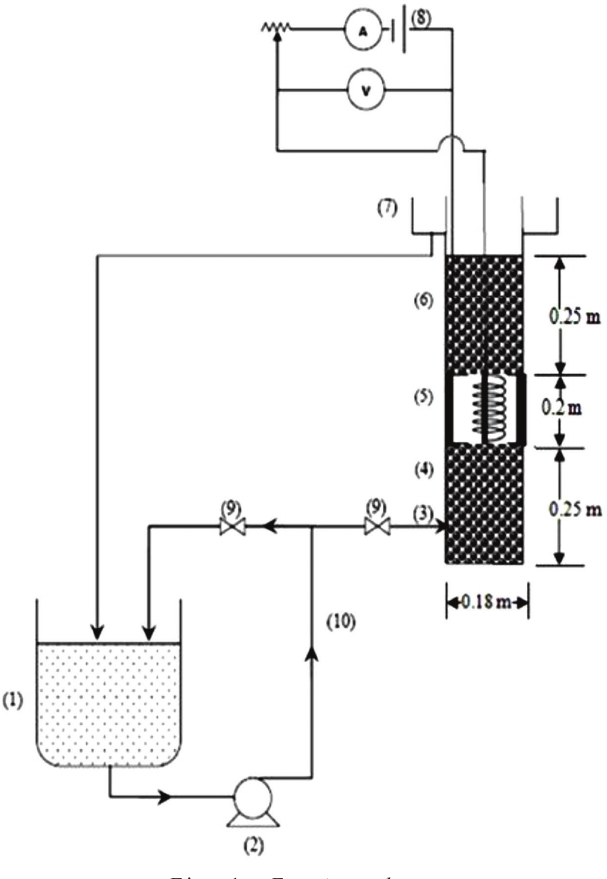
(1) Glass storage tank; (2) Plastic centrifugal pump; (3) So­ lution inlet; (4) Inlet calming section; (5) Working section (packed bed containing the electrolytic cell); (6) Outlet calming section; (7) Overflow weir; (8) D.C. power supply; (9) Plastic control valve; (10)